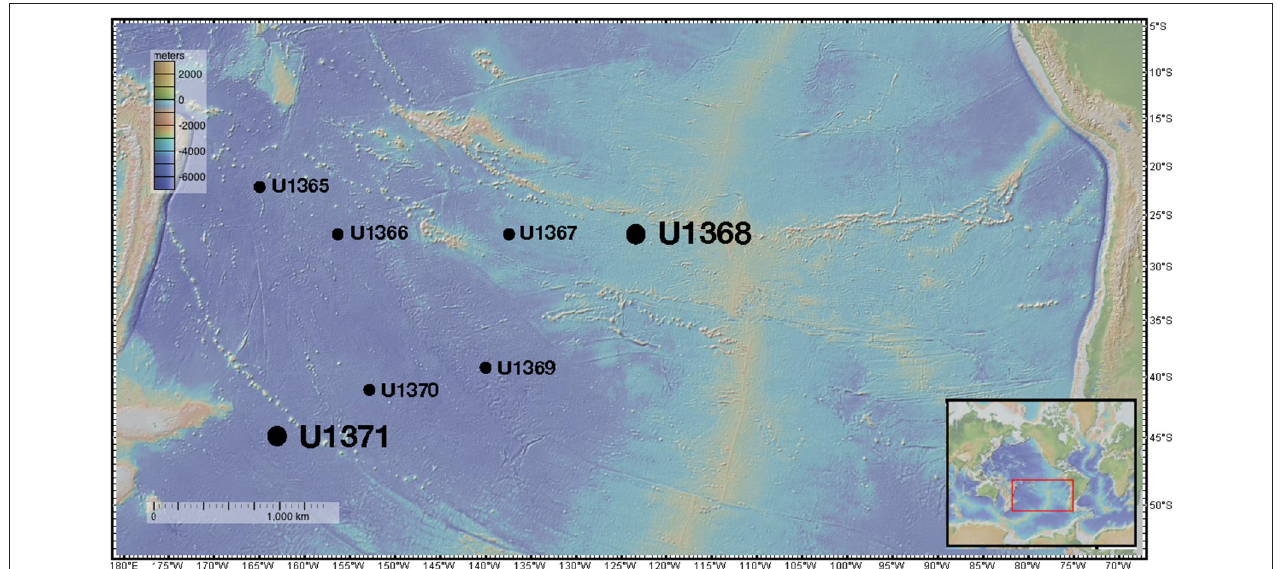
FIGURE 1 | Sampling locations of IODP Expedition 329. The large dots represent the locations from which the two main isolates characterized in this study were derived. Figure was made using GeoMapApp (Ryan et al., 2009).